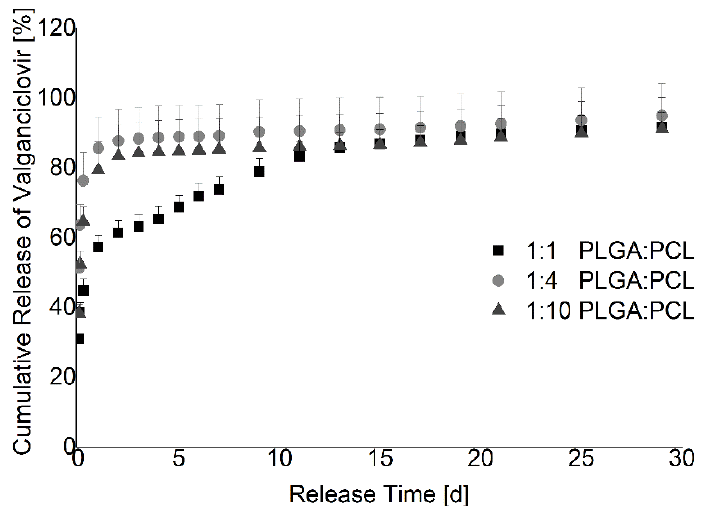
Figure 5. Cumulative release of valganciclovir out of films with more PCL. The graph shows the percentage of released drug out of 5% valganciclovir films versus the release time. Data for the film with PLGA and PCL in equal mass concentrations are depicted by the rectangles, the 1:4 PLGA to PCL film by the circles, and the 1:10 PLGA to PCL film by the